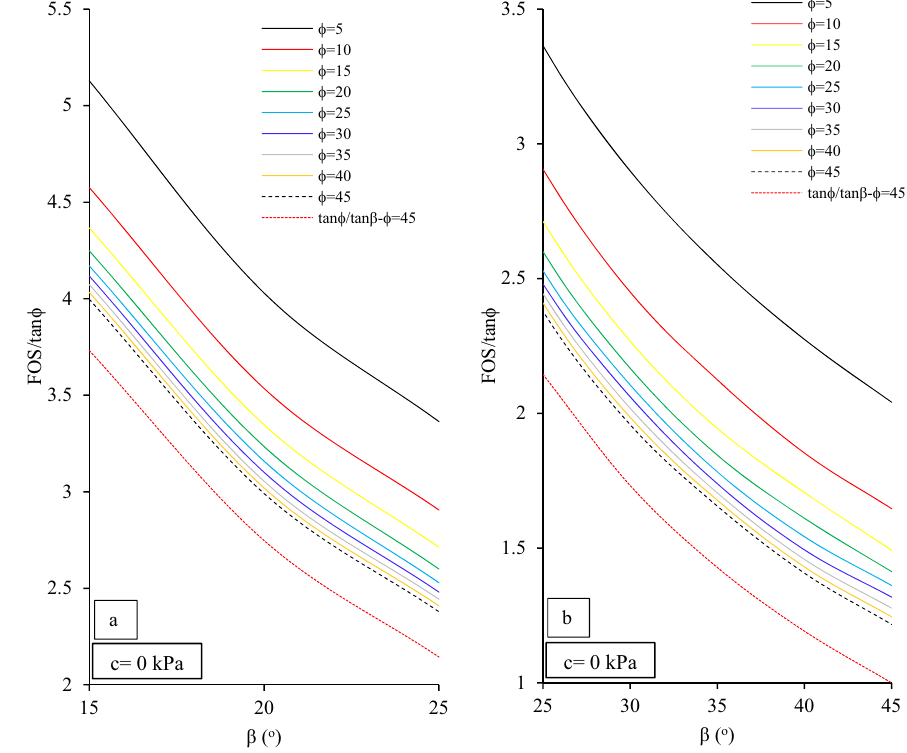
Figure 3: Stability charts for frictional soils ( c = 0 kPa ) for a range of β from ( a ) 15 – 25° and ( b ) 25 –